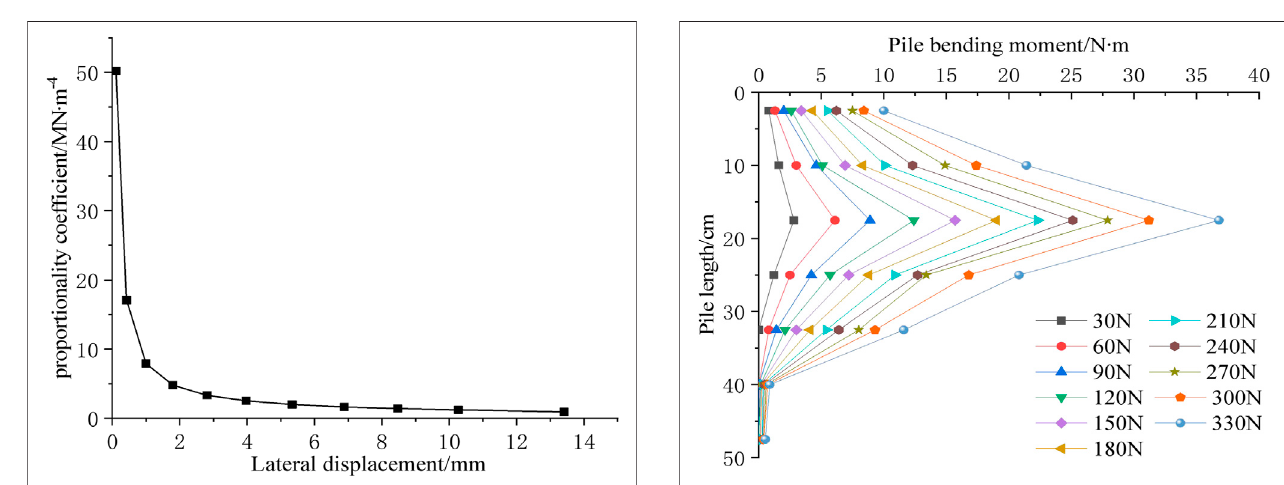
FIGURE 8 | Lateral displacement – proportional coef fi cient curve of composite foundation under static load.